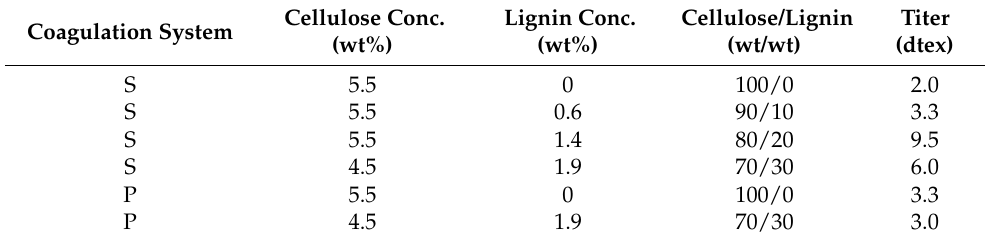
Table 2. Summary of the precursors